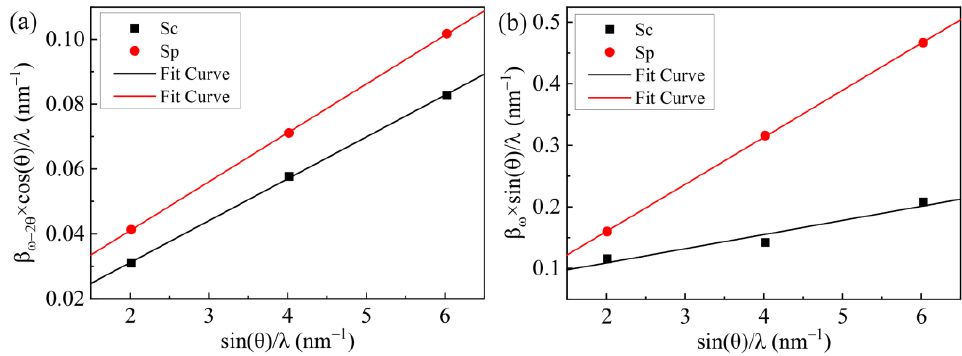
Figure 2. Williamson – Hall plots of AlN films for ( a ) ω–2θ scan an d ( b ) ω scan symmetric